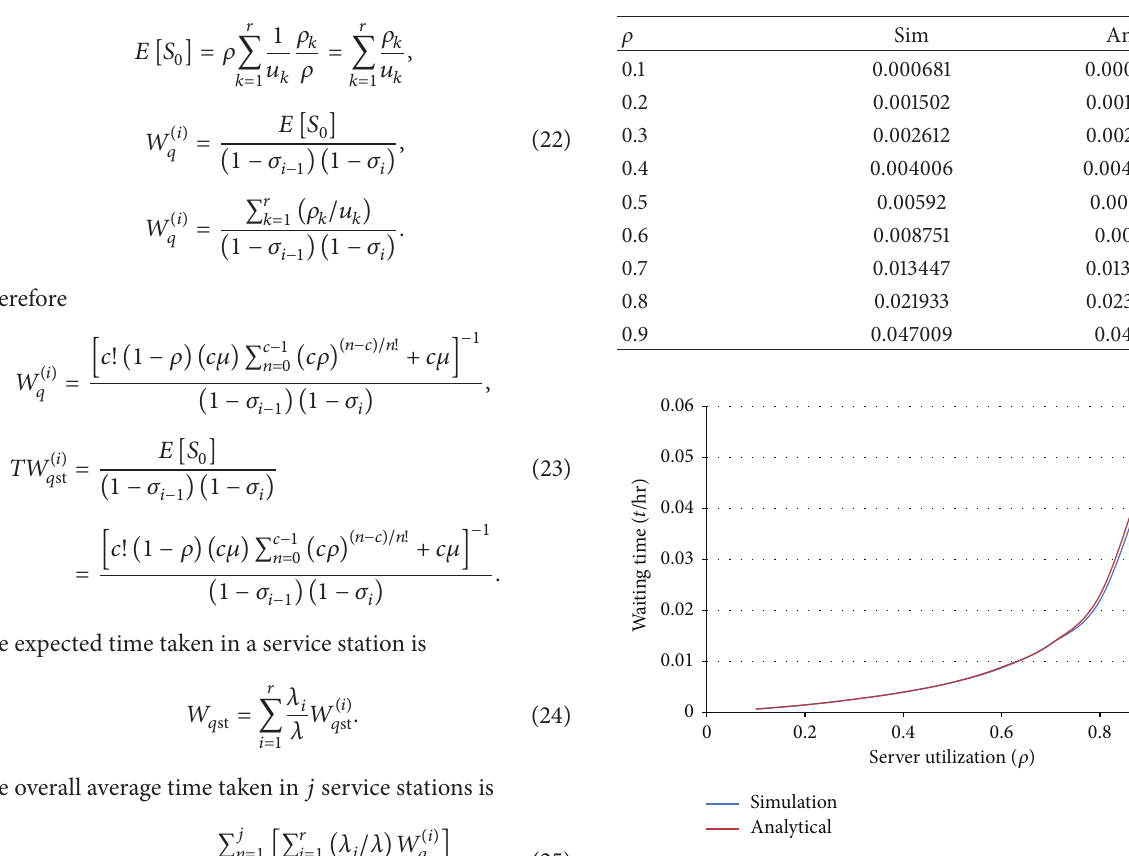
Table 2: Simulation and analytical.